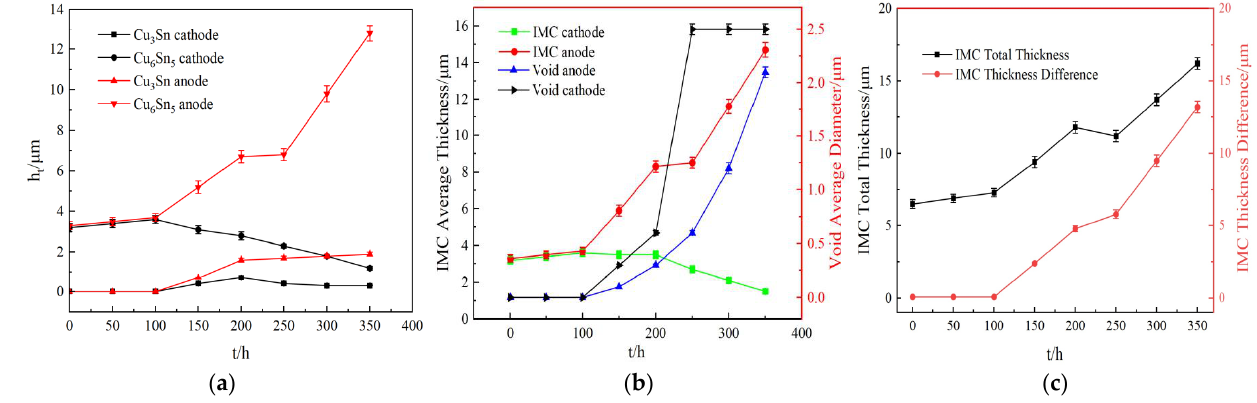
Figure 7. Relationship between the interfacial IMC of solder joints and the time under the current loading (j = 7 × 10 3 A/cm 2 ). ( a ) Thickness of cathode − side and anode − side Cu 6 Sn 5 and Cu 3 Sn. ( b ) Thickness of cathode − side and anode − side IMC and diameter of voids. ( c ) Total thickness of IMC and absolute thickness difference of